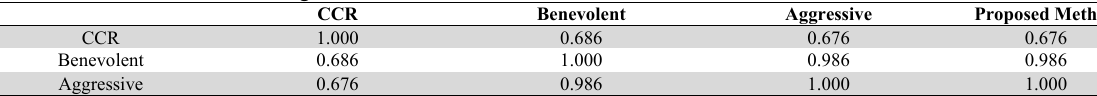
The correlation test for six nursing